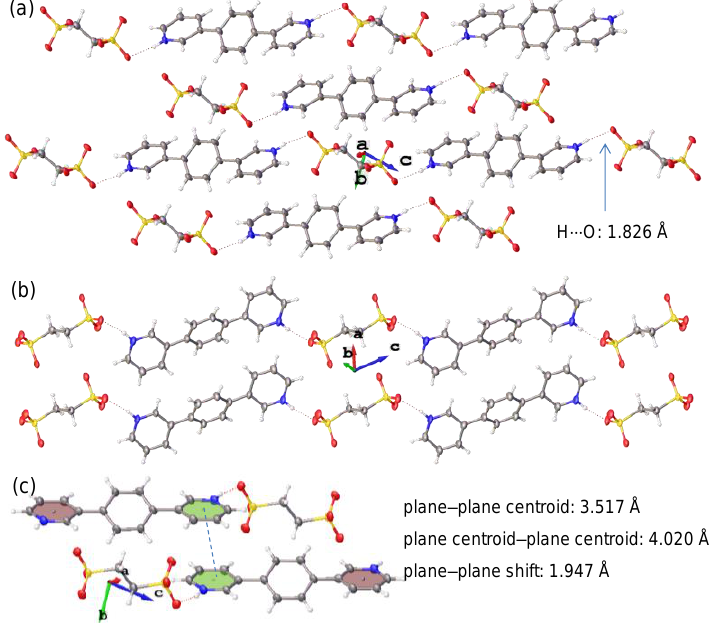
Figure 3. ( a , b ) Molecular packing of the single crystal of 5 viewed from the ( a ) a and ( b ) b axes, respectively. ( c ) Molecular stacking with potential π∙∙∙π interaction of 5 .